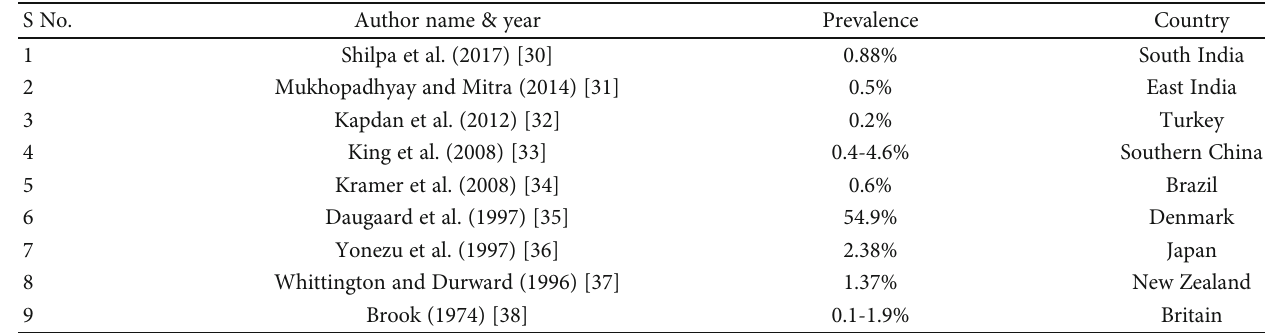
Table 2: The prevalence of nonsyndromic congenitally missing primary teeth worldwide. S